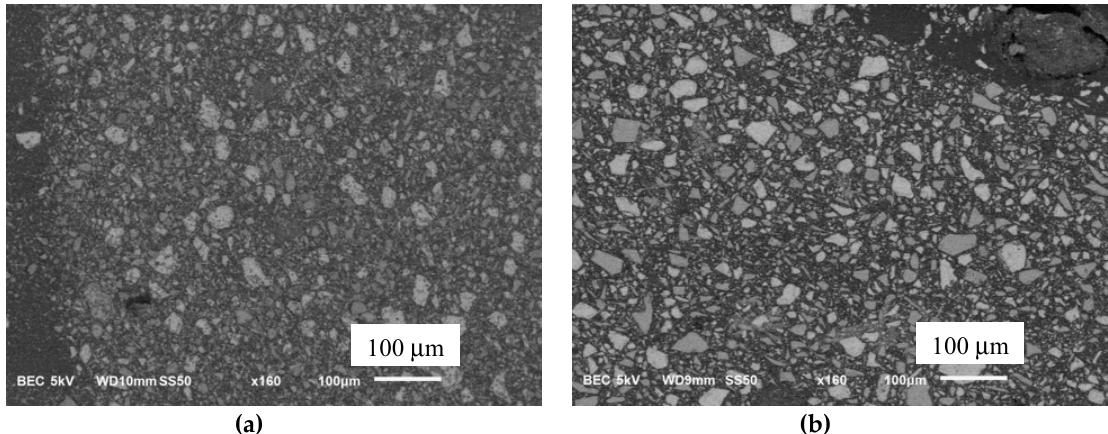
Figure 3. Heat flow of C, C-G1, and C-G2 pastes.